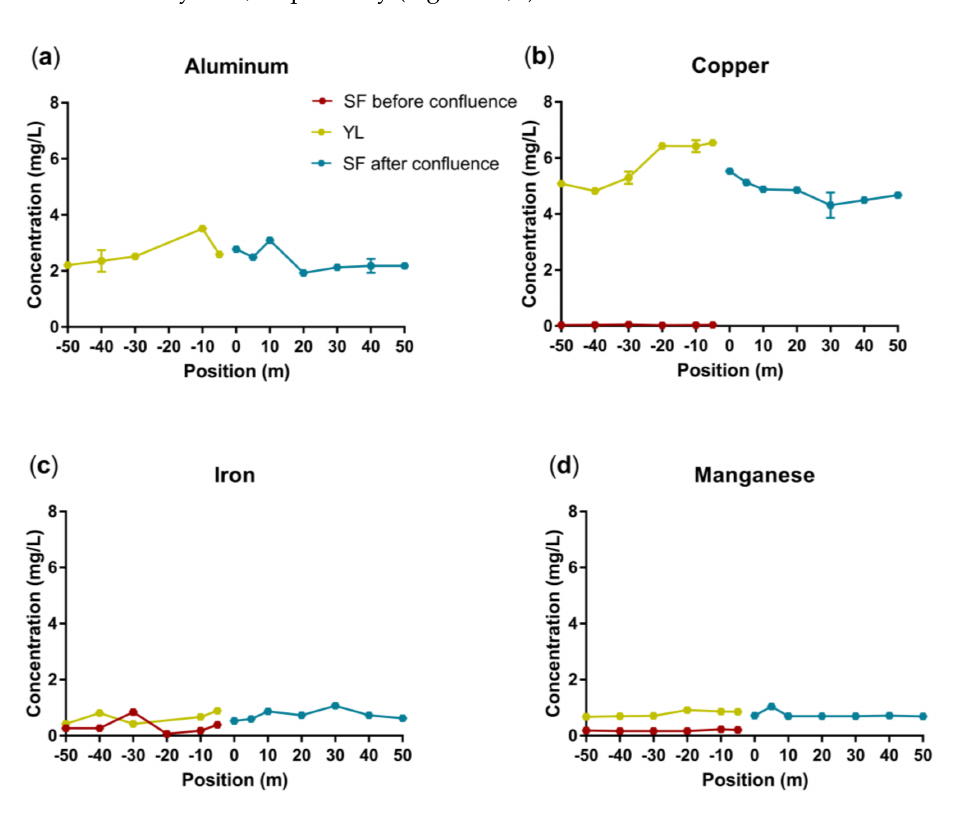
Figure 3. Dissolved concentrations of ( a ) Aluminum, ( b ) Copper, ( c ) Iron and ( d ) Manganese in the San Francisco River (SF) and Yerba Loca Creek (YL), before and after the confluence. Error bars correspond to the standard deviation of the measurements made in triplicate. In some cases, the error bars are not observed because the standard deviation of the results is very small. Aluminum concentration was not detected in the San Francisco River before the confluence ( a